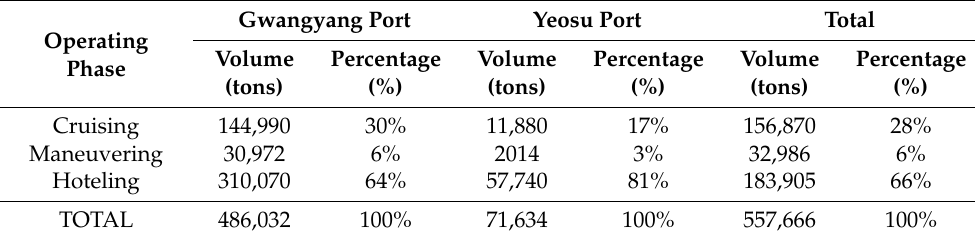
Table 8. Ship emissions by operating